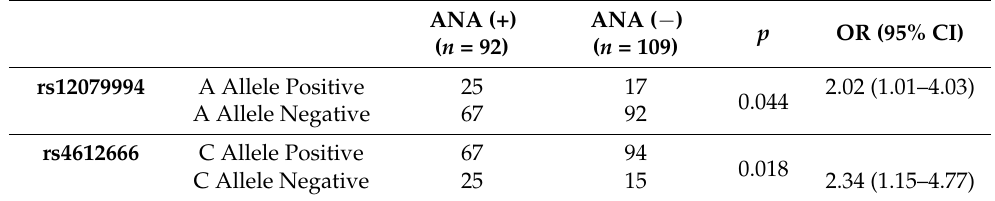
Table 5. Associations of alleles of NLRP3 genotype with ANA in primary Sjogren’s syndrome